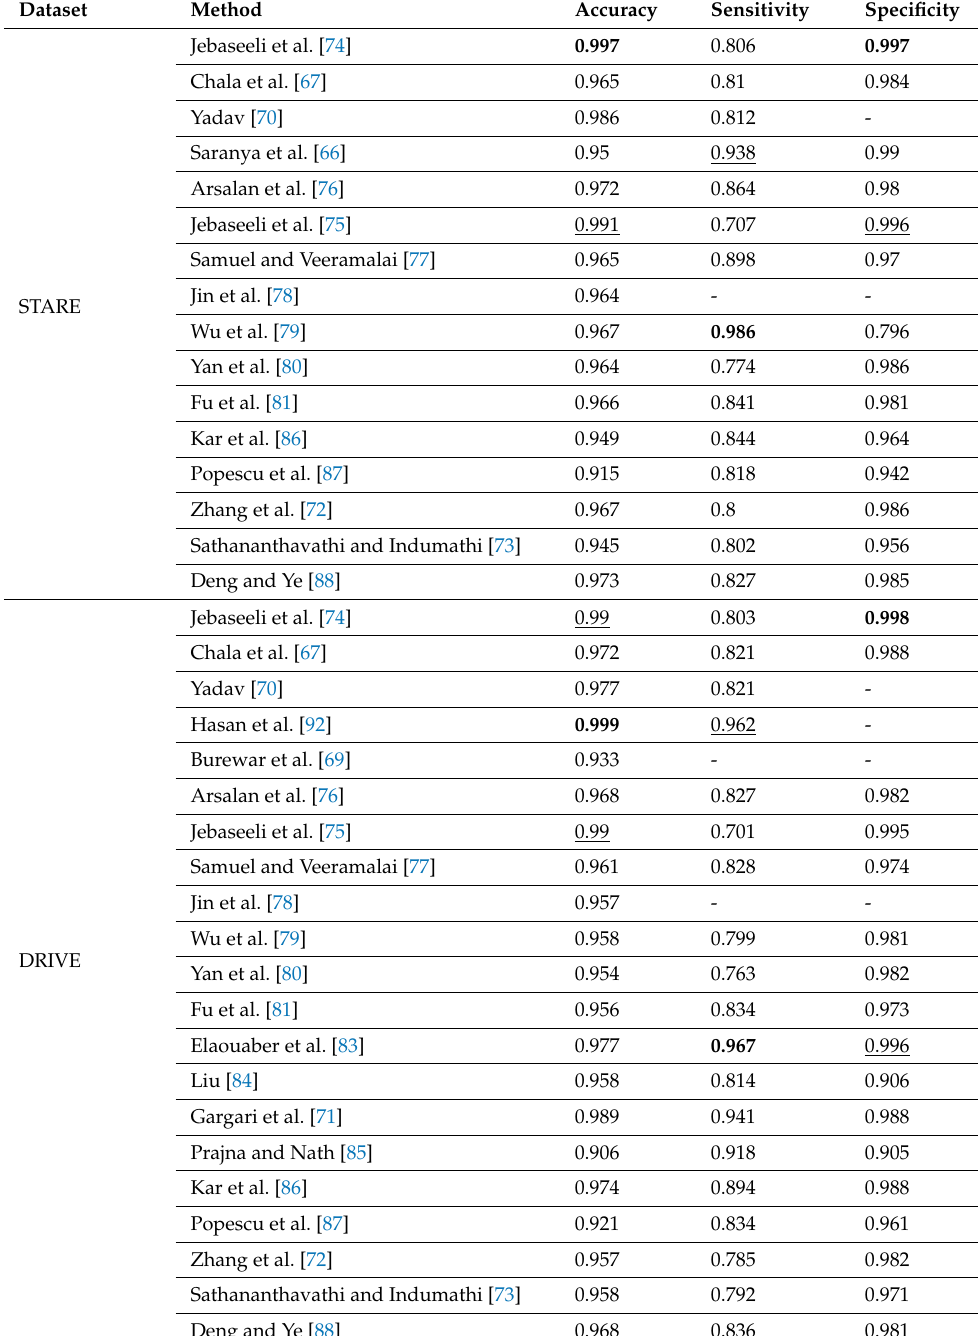
Table 4. Performance comparison of deep-learning based diabetic retinopathy segmentation.The bold and underlined fonts correspondingly show the first and second